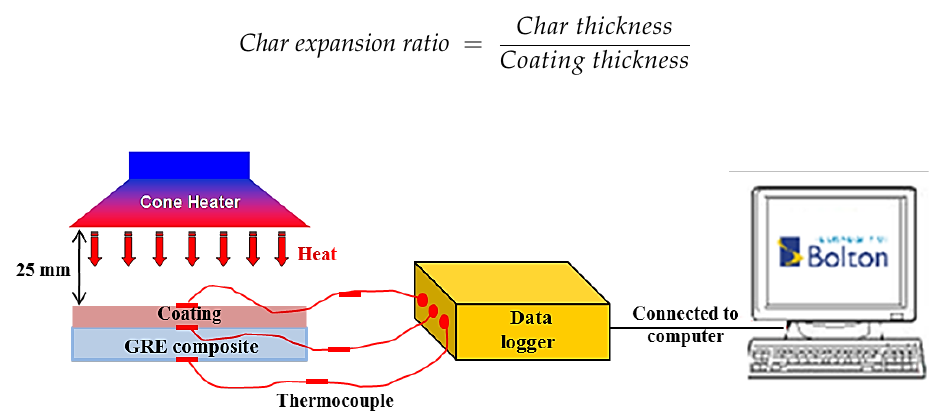
Figure 1. Experimental setup for temperature profile measurements in intumescent coated glass fibre-reinforced epoxy (GRE) composites during cone experiment at 50 kW/m 2.